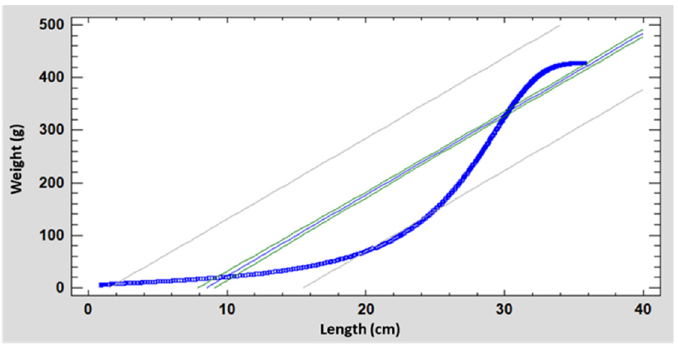
Figure 15. Regression analysis between two models (Logistic and Michaelis ‐ Menten).